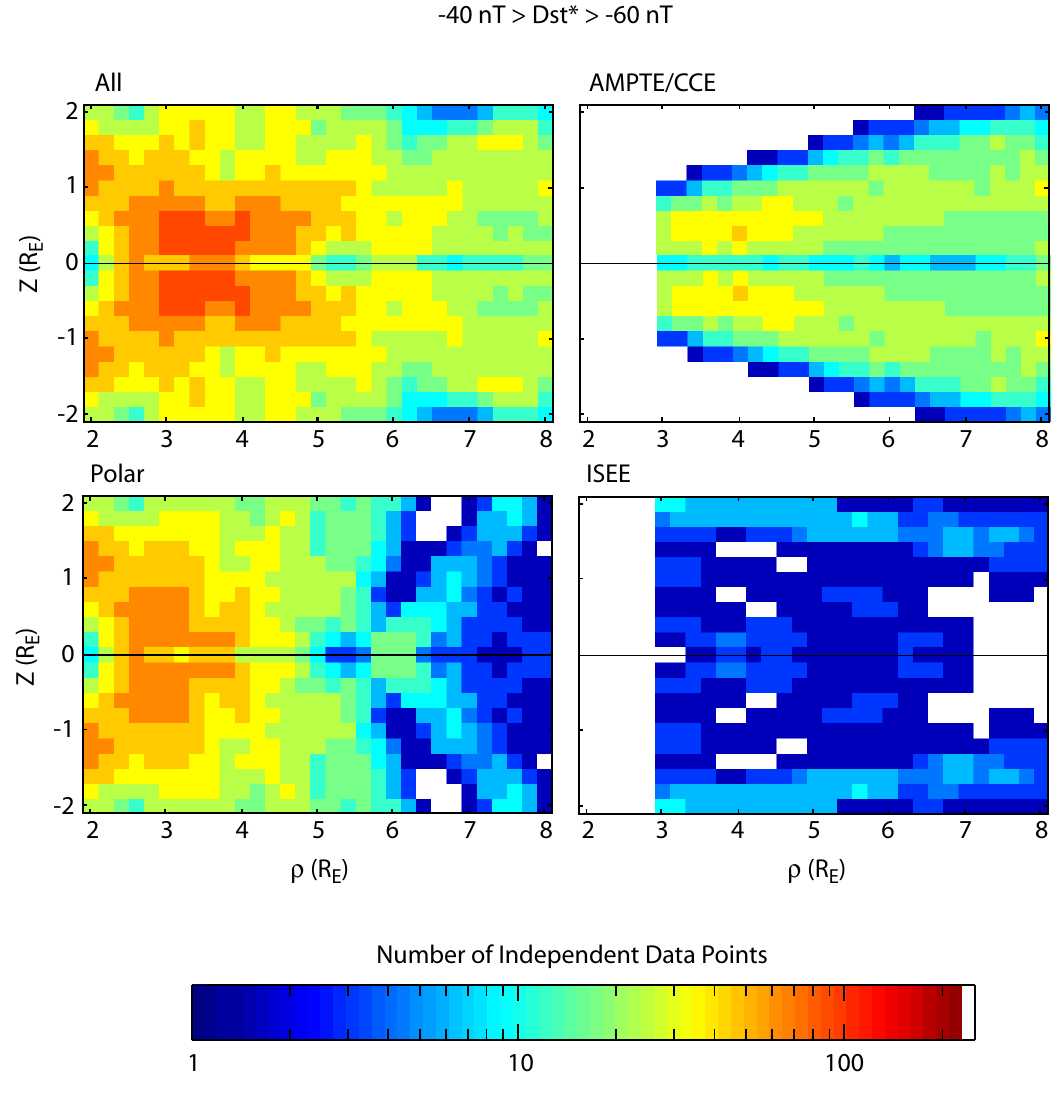
Fig. 2. Data coverage in the midnight plane for − 40nT >D st * > − 60nT for all data sets and for Polar, ISEE and CCE separately.